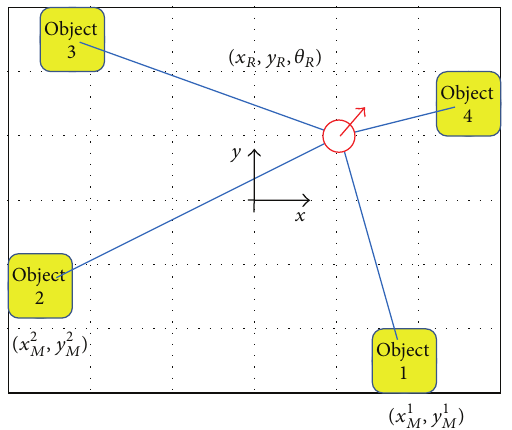
Figure 12: Localization problem is regarded as a coordinate trans- formation from reference coordinates to the robot coordinates.